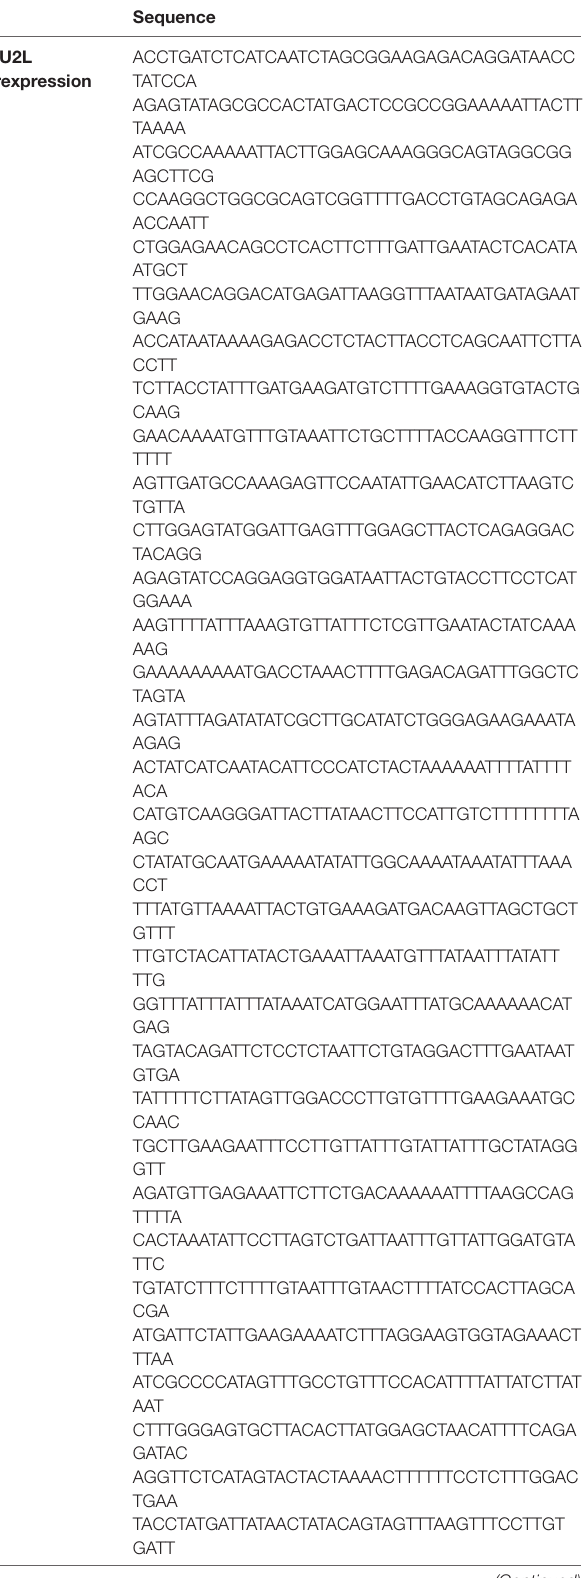
TABLE 1 | Overexpression and interference sequences for